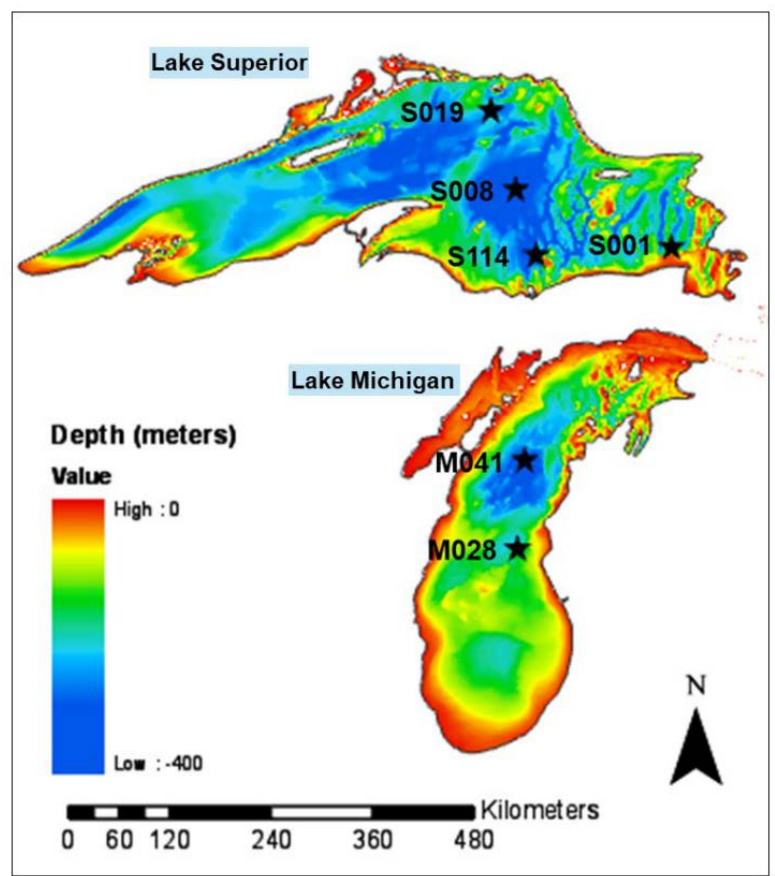
Figure 1. Sampling locations in Lake Michigan and Lake Superior. Sample collection locations in Lake Michigan (M028 and M041) and Lake Superior (S001, S008, S019, and S114) are shown with a star symbol. Geographical locations of the sampling sites are provided in Table S1.